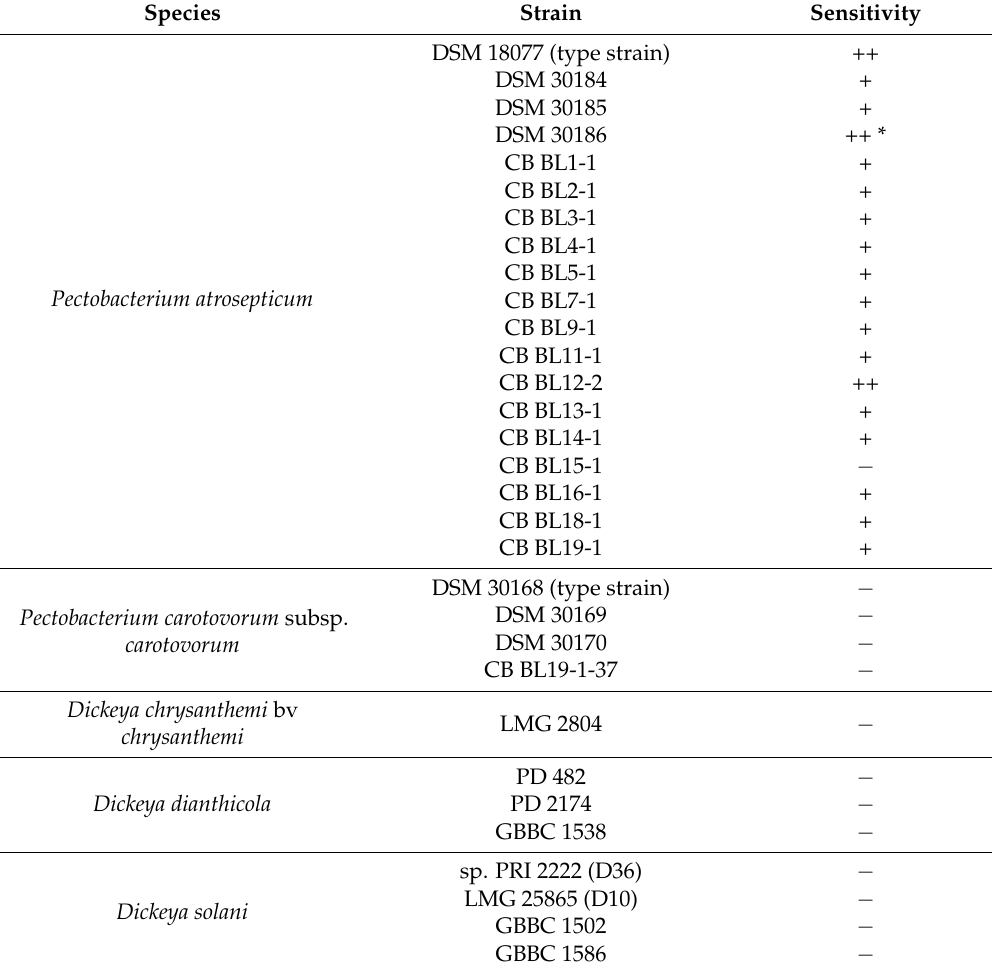
Table 1. Host range of Pectobacterium phage vB_PatP_CB5 (CB5) on 31 strains of the soft rot Enterobacteriaceae , determined by spot testing with serial dilutions of phage.